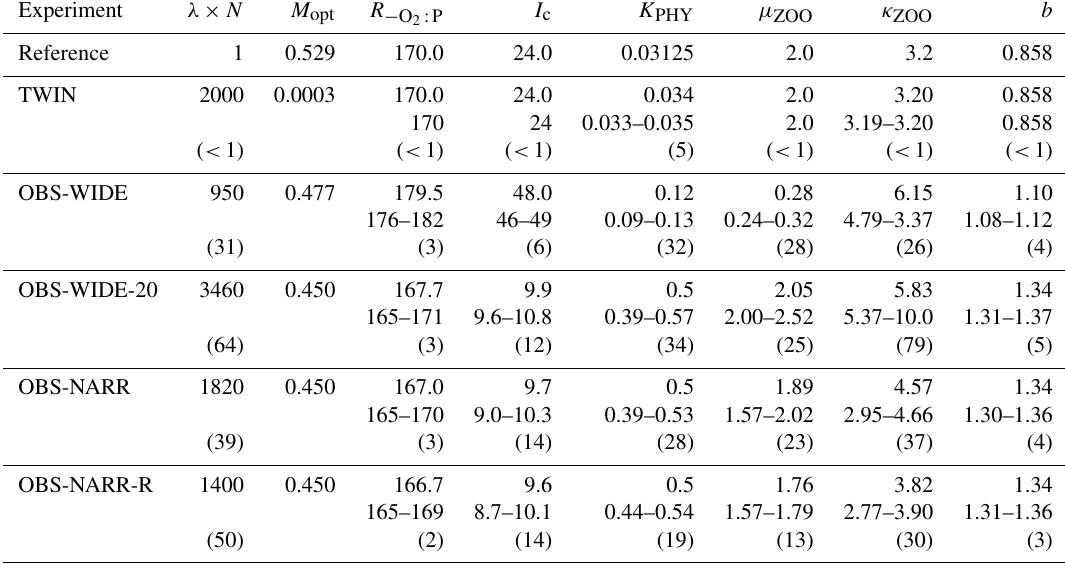
Table 3. Optimization results (evaluations, i.e., number of individuals, λ , times number of generations, N ), best model misfit M opt , optimum parameters, and their uncertainties. For each model and parameter, the first line gives the optimum parameter, followed by p min and maximum p max of all individuals, for which the misfit M i is (M i M opt )/M opt 0 . 001. The third line additionally presents in parentheses the percent − ≤ of individuals for which this criterion holds, as well as the range of optimum parameters as a percent of the average parameter of the last generation. We also give the misfit and parameters of the reference run, against which the twin experiment was